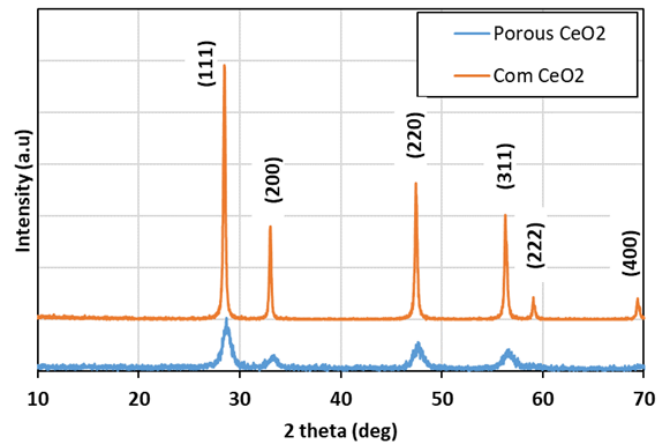
Figure 1. The XRD patterns of the porous ceria compared to that of commercial ceria .